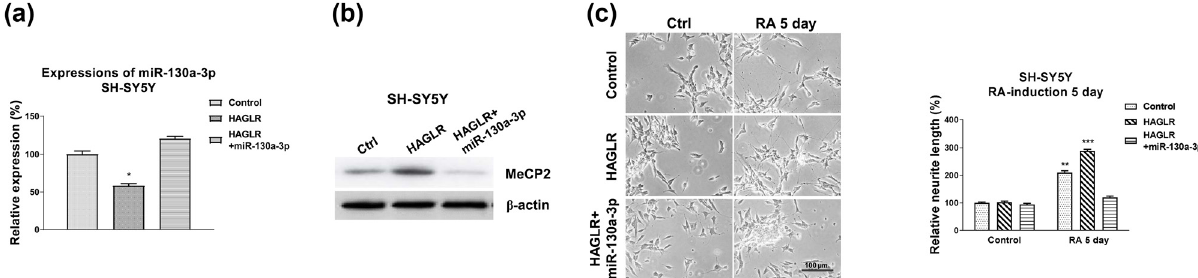
Figure 6: The HAGLR - miR - 130a - 3p - MeCP2 axis in neuron di ff erentiation. ( a ) SH - SY5Y cells were transfected with control, HAGLR alone, or with miR - 130a - 3p for 48 h; expression of miR - 130a - 3p was detected by qRT - PCR and ( b ) protein expression of MeCP2 was determined by western blot. ( c ) The above transfected cells were treated with 5 µM RA for 5 and 7 days. Cell morphologies were examined under a microscope, and the neurite length was measured. * p < 0.05 and ** p <